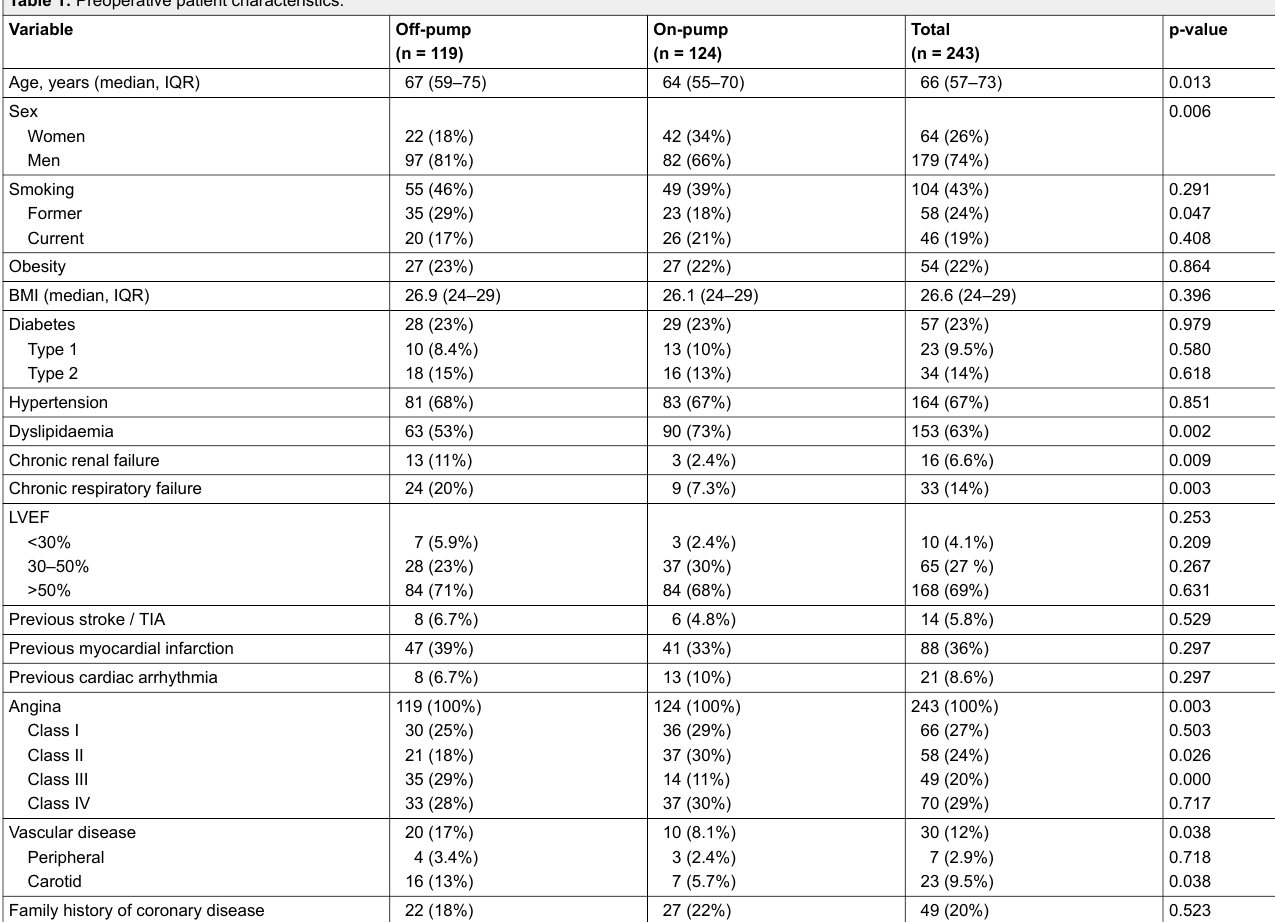
Table 1: Preoperative patient characteristics.